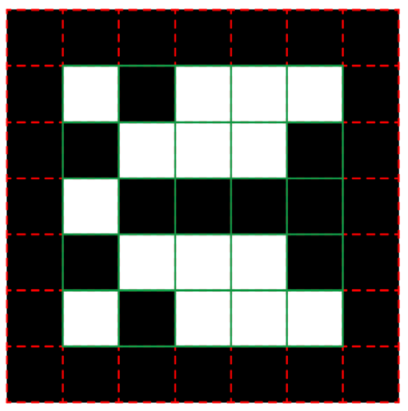
Figure 4. ArUco Markers diagram.